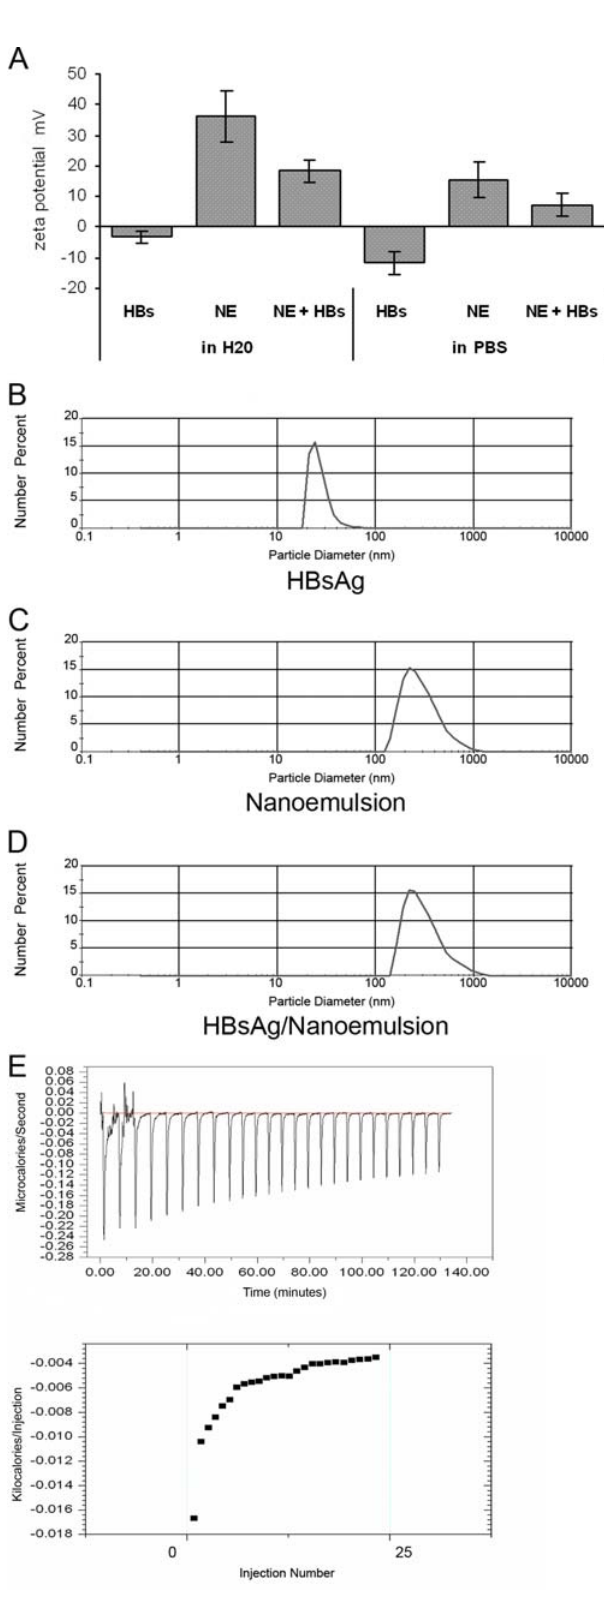
Figure 2. HBsAg interaction with NE droplets. Zeta potential: (A) The zeta potential was measured for HBsAg (2.5 mg/ml), 20% NE and mixture of HBsAg with NE (HBsAg-NE) in water and PBS. Surface charge is reported in mV units. Particle sizing: Size distribution